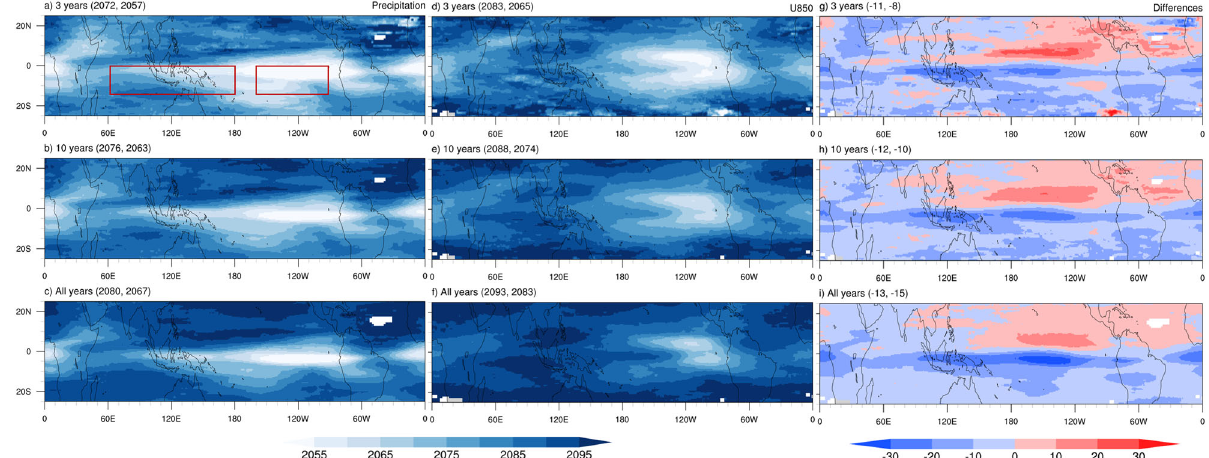
Fig. 3 Timing of MJO variability change signal under anthropogenic warming. a – f Ensemble mean of the projected year when MJO precipitation and wind amplitudes exceed the historical bounds with a , d 3 consecutive years, b , e 10 consecutive years, and c , f all subsequent years thresholds. g – i Differences between the left and right panels. The number in the parentheses shows the averaged projected year over the two boxes a for the Indo-Paci fi c warm pool (15°S-Eq., 60°E-180°) and central-eastern Paci fi c (15°S-Eq., 90°W-160°W), respectively. See Supplementary Figure 4 for the standard deviation across ensemble members.